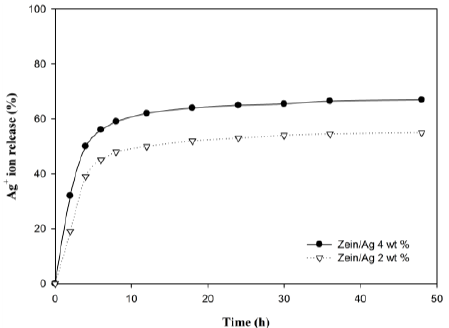
Figure 8. Ag + release from zein/Ag nanopartilces for different periods of time. The concentration of incorporated Ag nanoparticle in zein were 2 wt % and 4 wt %.